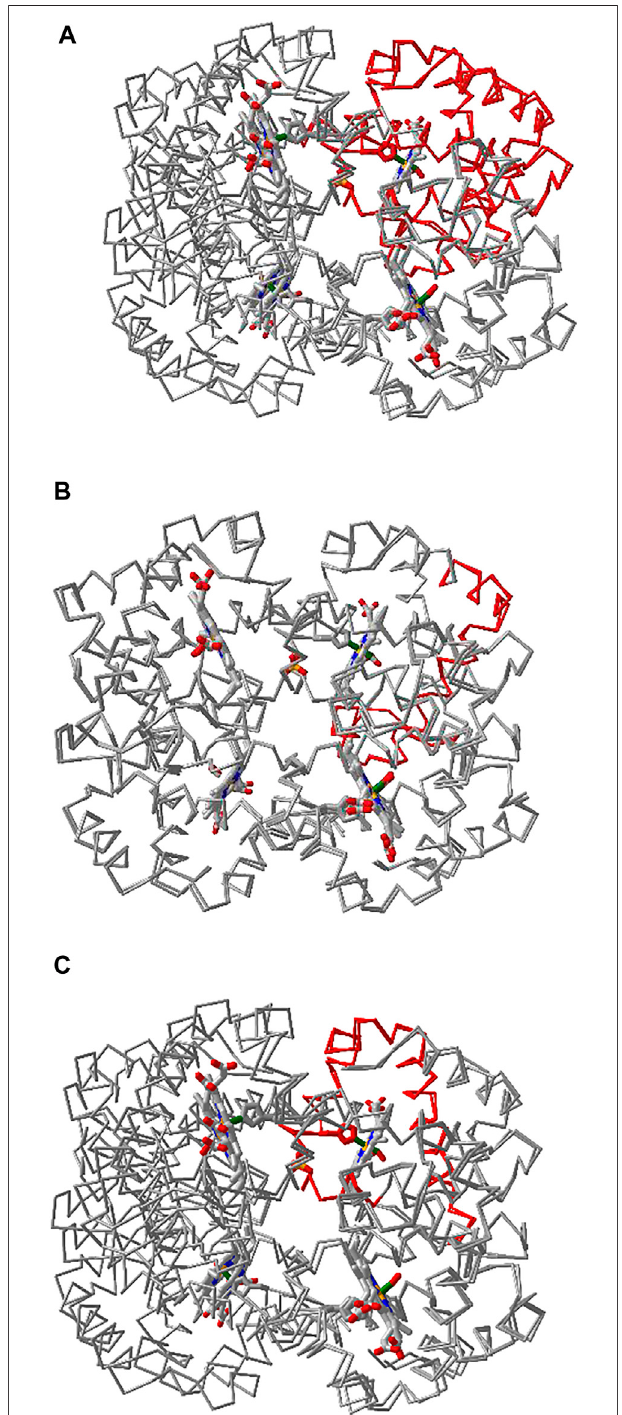
FIGURE 6 | Align witha subset ofresidues10 – 50inthe masterchain A ofPDB 1HHO. Thesharablelinkishttps://structure.ncbi.nlm.nih.gov/icn3d/share.html? QNcd4n3uHMn3wawG7www.ncbi.nlm.nih.gov/Structure/icn3d/full.html? chainalign=1HHO_A,2HCO_A&resnum = 10-50&resdef = &showalignseq = 1. (C) Align with pre-de fi ned residues: 50 – 100 in chain A of PDB 4N7N and residues50 – 100inchainAofPDB1HHO.Thesharablelinkishttps://www.ncbi. nlm.nih.gov/Structure/icn3d/full.html?chainalign=1HHO_A,4N7N_A&resnum = &resdef = 50 – 100+|+50 – 100&showalignseq =